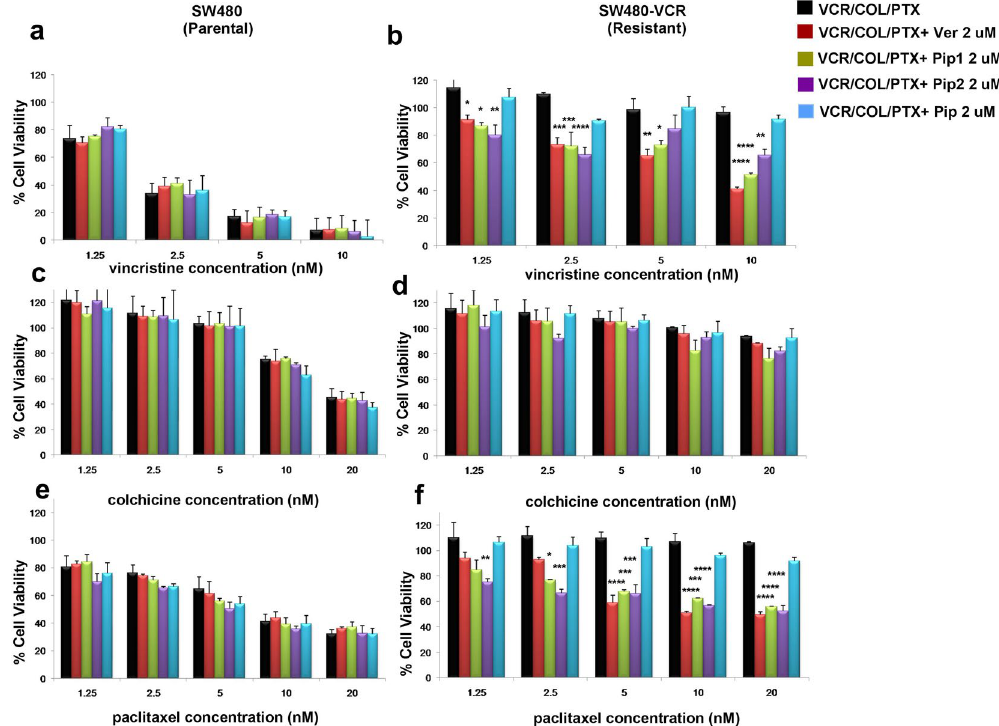
Figure 7. Cytotoxicity of vincristine (VCR) in ( a ) SW480 (parental), and ( b ) SW480-VCR (resistant); colchicine (COL) in ( c ) SW480 (parental), and ( d ) SW480-VCR (resistant); paclitaxel (PTX) in ( e ) SW480 (parental), and ( f ) SW480-VCR (resistant) cells. The cells were treated either with VCR/COL/PTX alone or in combination with Verapamil (Ver), Pip1, Pip2 or piperine (Pip). Values with error bars represent the mean ± SEM of two independent experiments, each done in triplicates. * p < 0.05 and ** p < 0.005, *** p < 0.0005 and **** p <